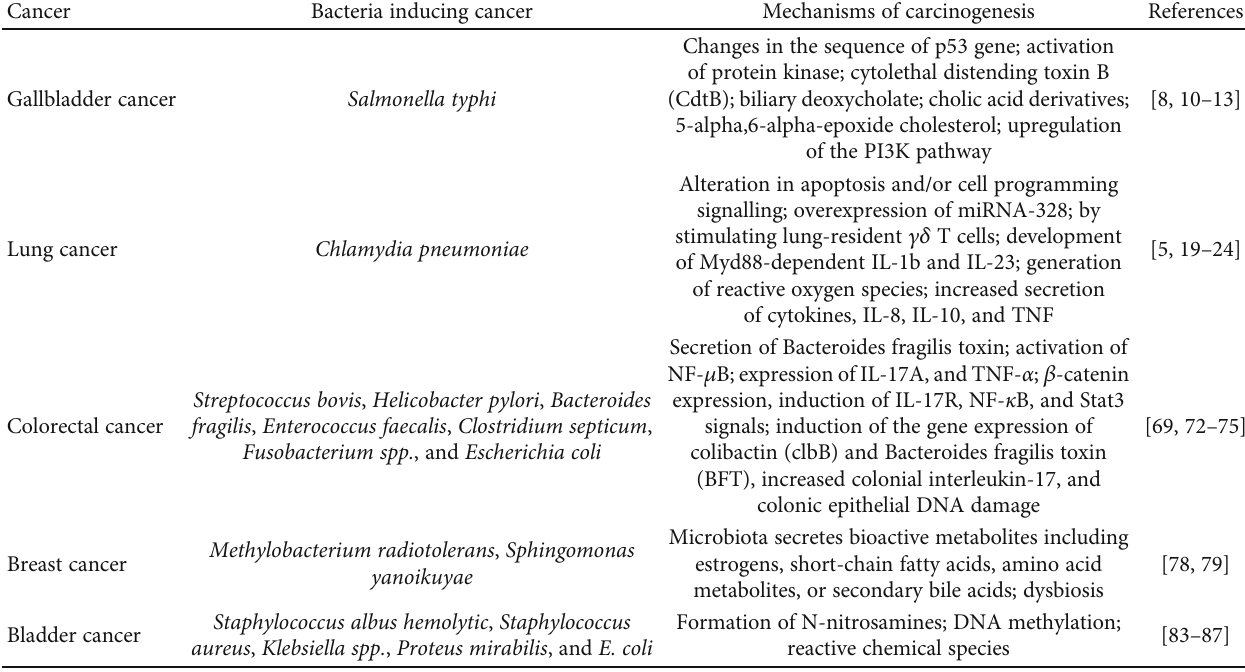
Table 1: Types of cancer induction and mechanisms of carcinogenesis induced by di ff erent